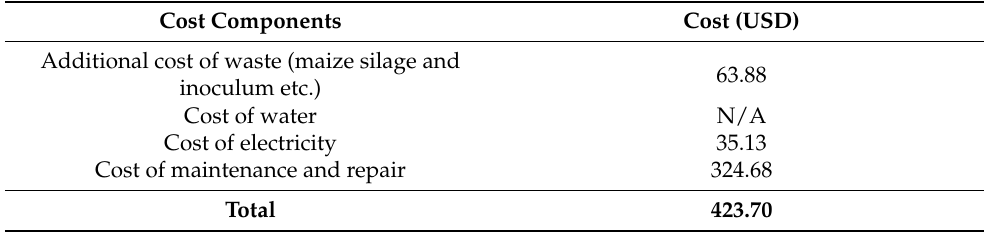
Table 6. Annual operating cost for the biogas digester. Cost